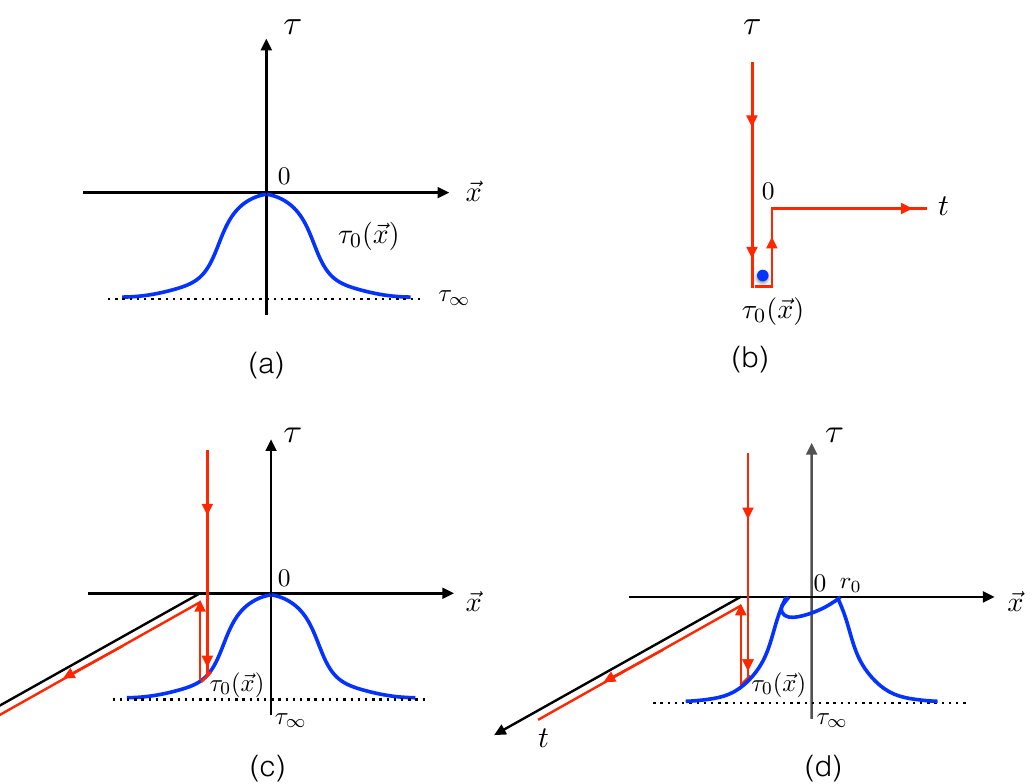
Figure 1 . Figure (1a) shows the singularity surface (cid:28) = (cid:28) 0 ( ~x ) of the (cid:12)eld con(cid:12)guration h on the imaginary-time hyper-plane ( (cid:28); ~x ). The tip of the singularity surface is located at (cid:28) = 0 so that in Minkowski space-time the solution is singular only at a single point taken to be the origin ( t; ~x ) = (0 ;~ 0). Away from the local maximum, the singular domain-wall (cid:28) 0 ( ~x ) approaches the constant space-independent value (cid:28) 1 . Figure (1b) shows the time-evolution contour on the complex time plane. The two turning points are the location of the singularity surface, (cid:28) 0 ( ~x ), and the origin, (cid:28) = 0 = t , after which evolution to the (cid:12)nal state proceeds along the real t axis. Figure (1c) shows the same time-evolution contour at a (cid:12)xed value of ~x along with the singularity surface of the classical (cid:12)eld in the complex-time-space coordinate system ( t; (cid:28); ~x ). Figure (1d) is the same as (c), but the singular domain wall (cid:28) 0 ( ~x ) is folded into the real time direction for j x j < r 0 where r 0 is the critical radius of the domain wall